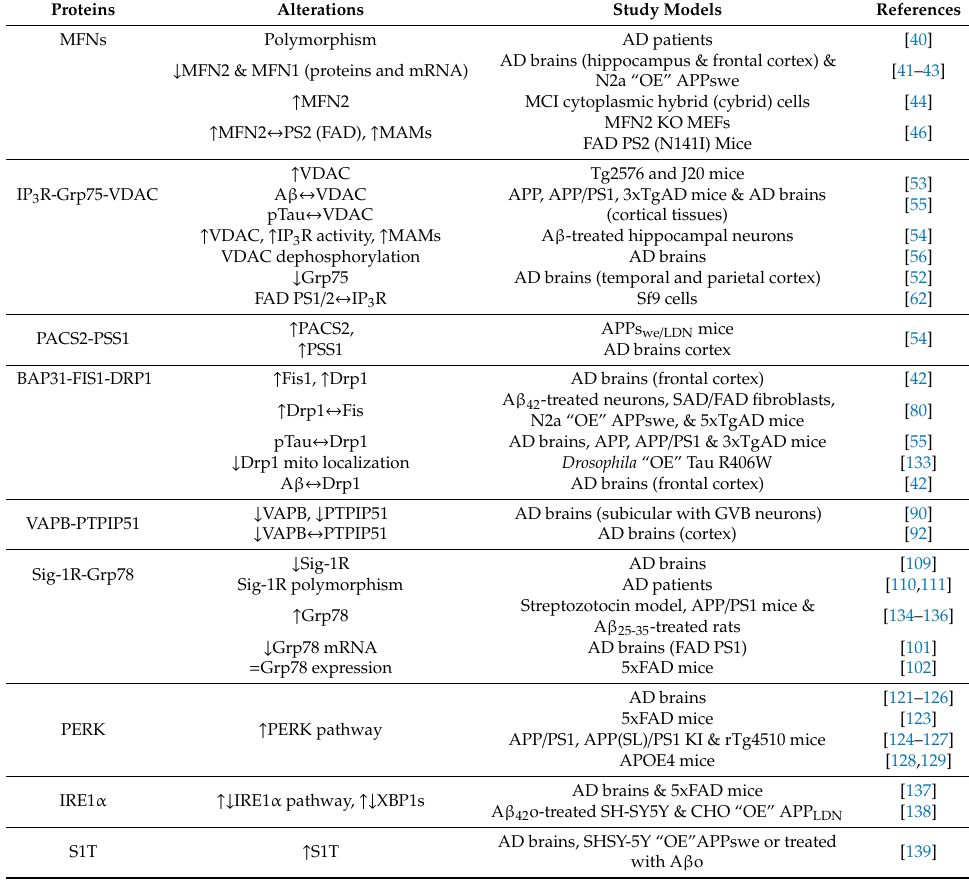
Table 1. MAMs molecular component alterations in AD. These alterations include reduced ( ↓ ), increased ( ↑ ), unchanged expressions ( = ), or interaction ( ↔ ) between proteins observed in AD study models and human-derived samples (SAD brains and SAD / FAD fibroblasts); KO: knock-out; KI: knock-in; “OE”: overexpressing; MCI: mild cognitive impairment; GVB: granulovacuolar degeneration bodies; A β o: A β